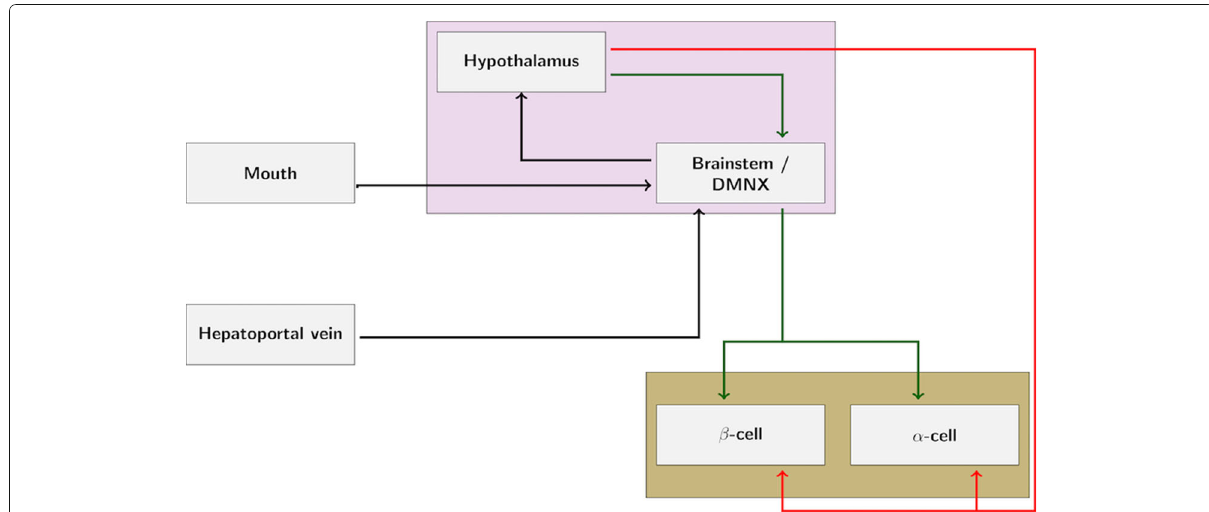
Fig. 3 Schematic of the nervous reflex involving neural glucose sensing that controls pancreatic secretion. Glucose in the oral cavity and in the hepatoportal vein area induces pancreatic secretion by mechanisms that integrate afferent nerves that project from the taste buds and the hepatoportal vein to the brainstem and hypothalamus and efferent nerves from these areas to the pancreas. Green lines: parasympathetic innervation (via release of the neurotransmitters ACh, VIP, PACAP, GRP); Red lines: sympathetic innervation (via release of the neurotransmitters NE, NPY,